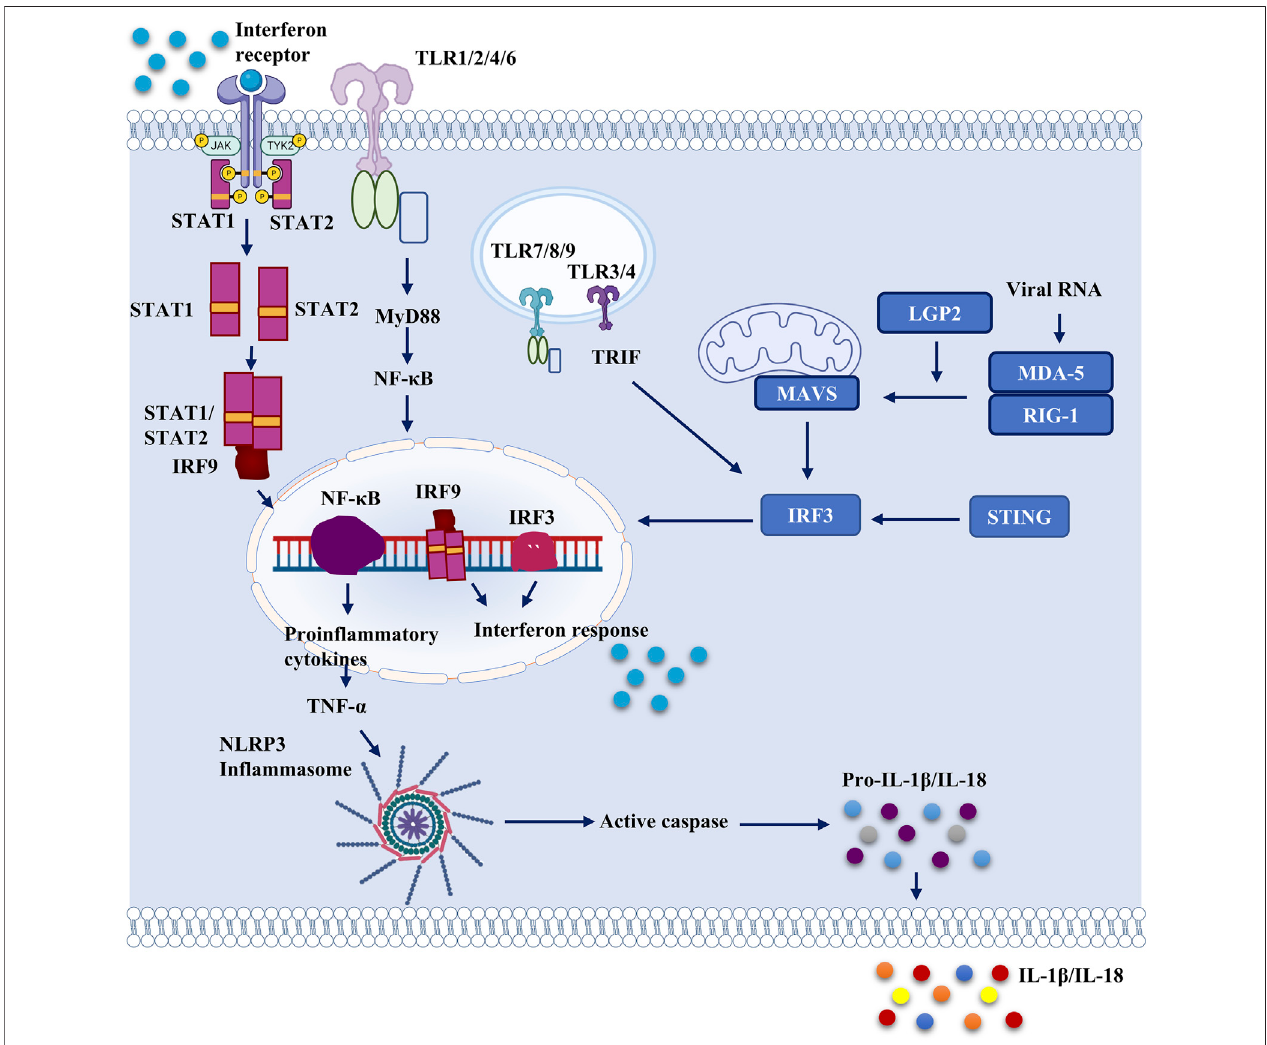
FIGURE 2 | Important pattern recognition receptors and cellular proteins which can serve as potential therapeutic targets against SARS-CoV-2. Different cellular receptors can be activated by viral proteins and viral genome. Structural proteins of SARS-CoV-2 activate membrane bound toll-like receptors and they activate NF- κ B by MyD88 activation. Endosomal TLRs are activated by viral structural as well as non-structural proteins, which also activate NF- κ B and downstream signaling. Thus, proin fl ammatorycytokinesarereleasedfromthecell.Proin fl ammatorycytokinesfurtheractivatetheNLRP3in fl ammasomewhichleadstosecretionofIL-1 β andIL- 18. NLRP3 in fl ammasome is activated directly too by viral proteins including ORF3a and non-structural proteins. STING expression is also dysregulated by ORF3a, and 3CLpro. Nucleocapsid and Membrane protein blocks IRF3 phosphorylation and attenuates interferon response. It also interferes with RIG-1. Various SARS-CoV-2 proteins have been reported to interfere with RIG-like receptor